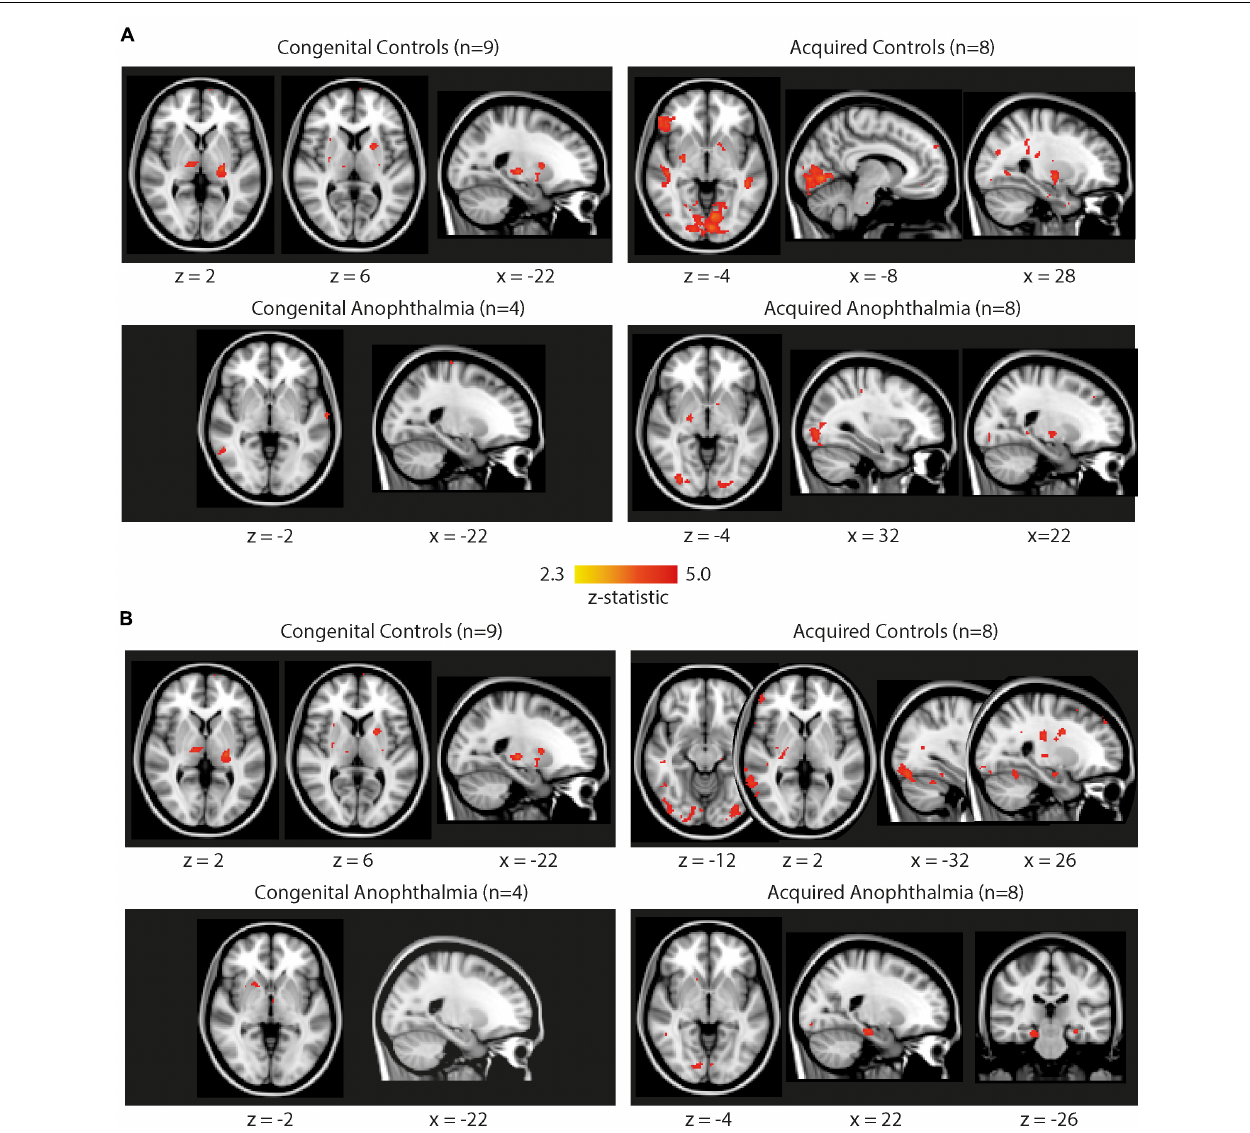
FIGURE 2 | Whole-brain functional activation during the no light condition for each subject group (congenital controls, acquired controls, congenital anophthalmia, acquired anophthalmia). (A) Shows results when applying the same 30 s ON/OFF block design as the light conditions in Figure 1 . (B) Shows results using a 15 s ON/OFF block design. For visualization purposes, statistical maps are thresholded at Z > 2.3 (uncorrected) and overlaid on MNI standard brain using FSLview. No results survive cluster correction.